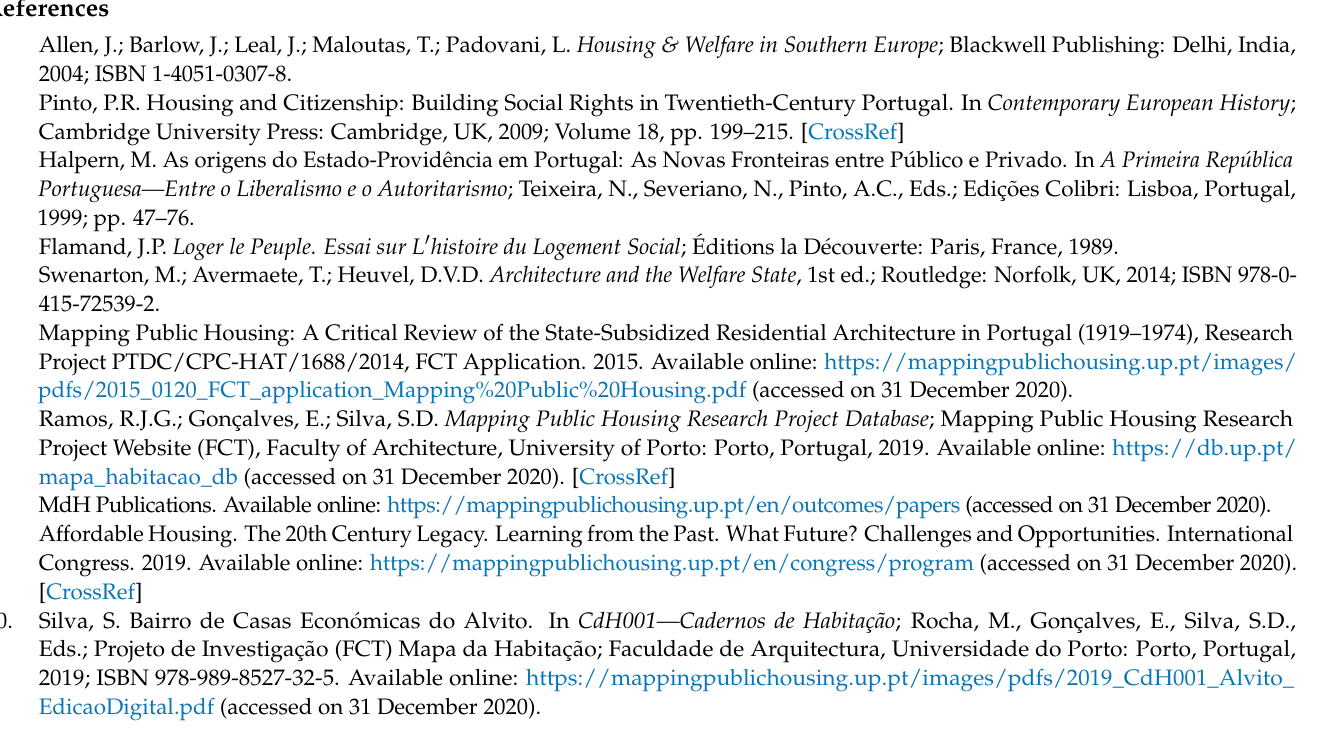
Figure A6. Linear chart. No. of built estates per housing programme. Source: MdH database, 2019. Universe: built estates and phases included in MdH between 1910 and 1974, and number of dwellings. Error factors: in some cases, the number of dwellings is an estimate; the reference date is the first known date; in the case of large urban plans—such as Olivais Norte, Olivais Sul and Chelas—the values entered are the date of the plan and the projected number of dwellings (sep-arate parts of these are not considered in the graphs and are recorded in the database due to their architectural relevance). Data